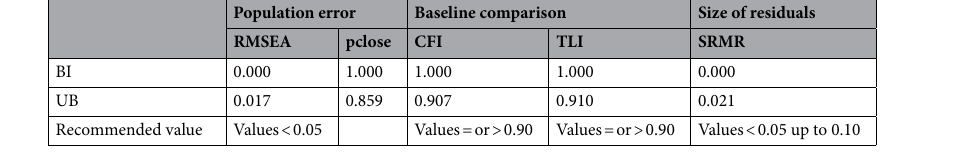
Table 7. The goodness of fit